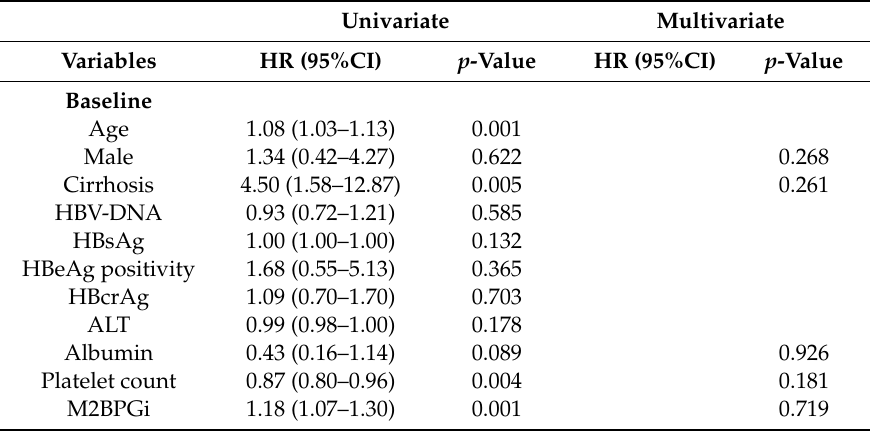
Table 2. Univariate and multivariate analyses for factors associated with HCC